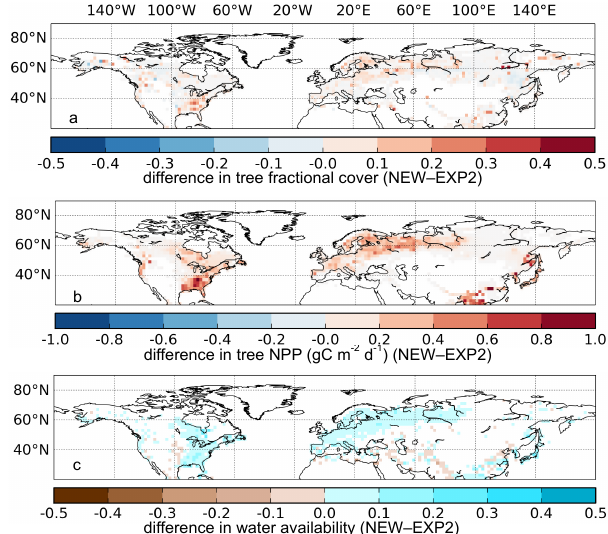
Figure 13. Difference of tree fractional cover (a) , tree NPP (gCm − 2 d − 1 ) (b) and WA (c) between with and without CO 2 ris- ing (NEW–EXP2). NPP is averaged over tree PFTs (PFTs 2–9) weighted by their fractions. WA is averaged over the growing sea- son (May–September) and over tree PFTs (PFTs 2–9) weighted by their